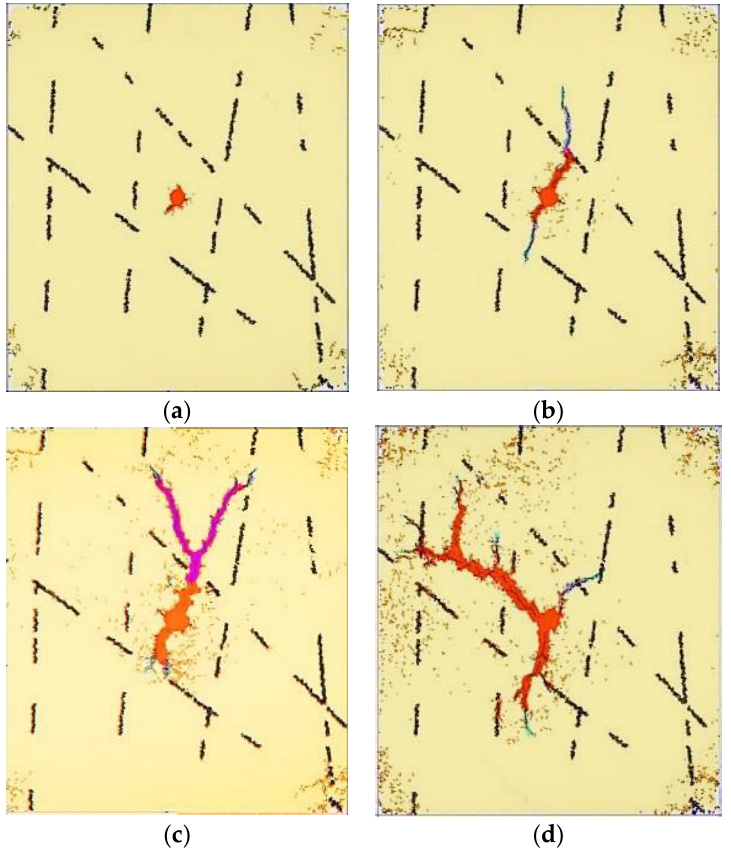
Figure 6. The contact-bond fracture and micro-fracture generation for the different injection pressure. ( a ) P 0 = 30 MPa. ( b ) P 0 = 40 MPa. ( c ) P 0 = 50 MPa. ( d ) P 0 = 60 MPa.